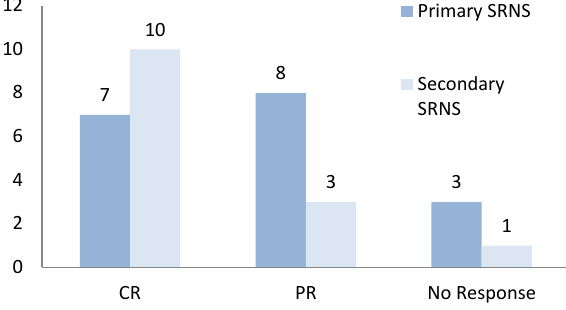
Figure 2. Response to therapy in two clinical subgroups (n).